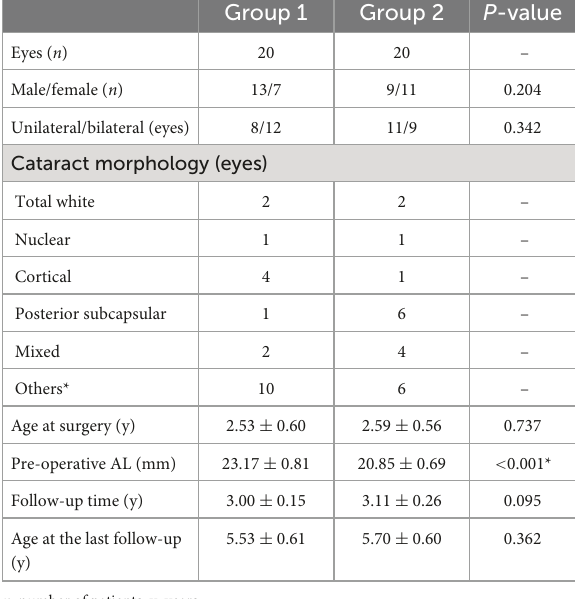
TABLE 1 Characteristics of the two groups.